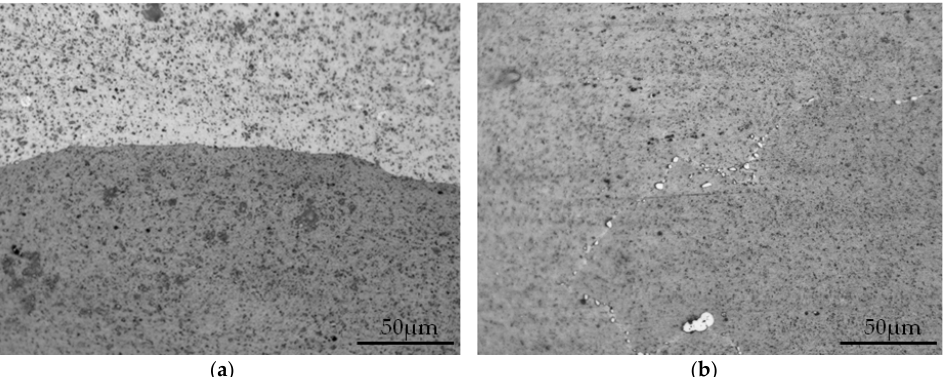
Figure 7. Optical micrographs of solution treatment followed by water quenching 2219 Al- x Cu alloys: ( a ) 5.56%, ( b ) 6.52%.